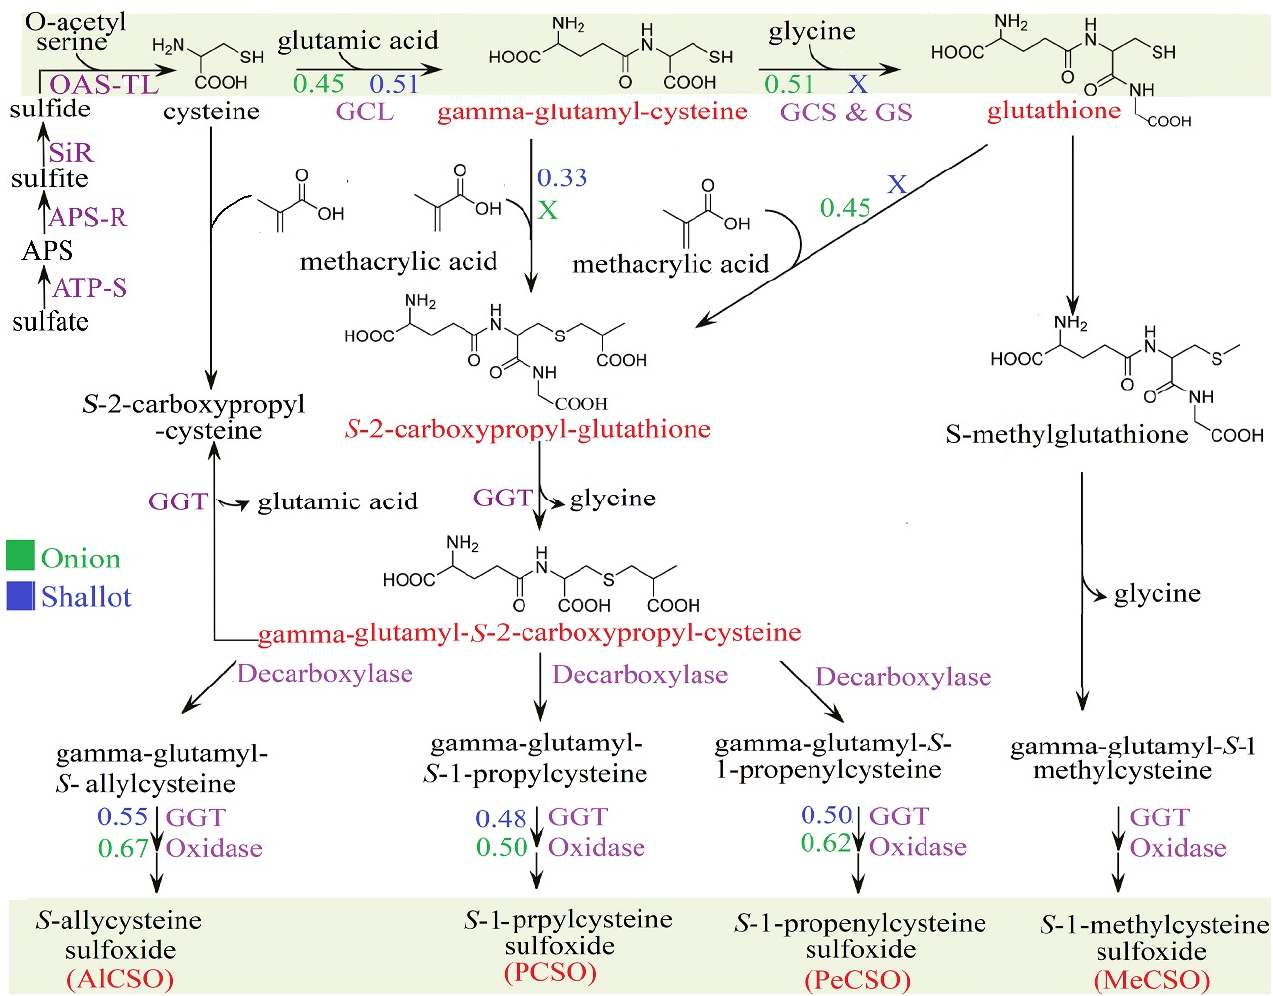
Figure 6. Putative pathways for the biosynthesis of S-alk(en)yl-L-cysteine sulfoxide compounds in shallots and bulb onions. The sulfur assimilation pathway in onion begins with the activation of sulfate (SO 42 − ) to adenosine 5 ′ -phosphosulfate (APS), a reaction catalysed by ATP-sulfurylase (ATP-S). APS is reduced to sulfide (S 2 − ) in a two-step process catalysed by the enzymes APS-reductase (APS-R) and sulfite reductase (SiR). The generated S 2 − incorporated into cysteine, a donor of reduced sulfur for all further S-containing metabolites. Biosynthesis of S -alk(en)yl-l-cysteine sulfoxides is initiated by S -alk(en)ylation of glutathione, which is followed by the removal of glycyl and γ -glutamyl groups and S-oxygenation. Values represent Pearson correlation coefficients of the investigated genotypes. GCL, gamma-glutamylcysteine synthetase; GS, glutathione synthetase; GGT, gamma-glutamyl transpeptidase; OAS-TL, O -acetylserine (thiol)-lyase.